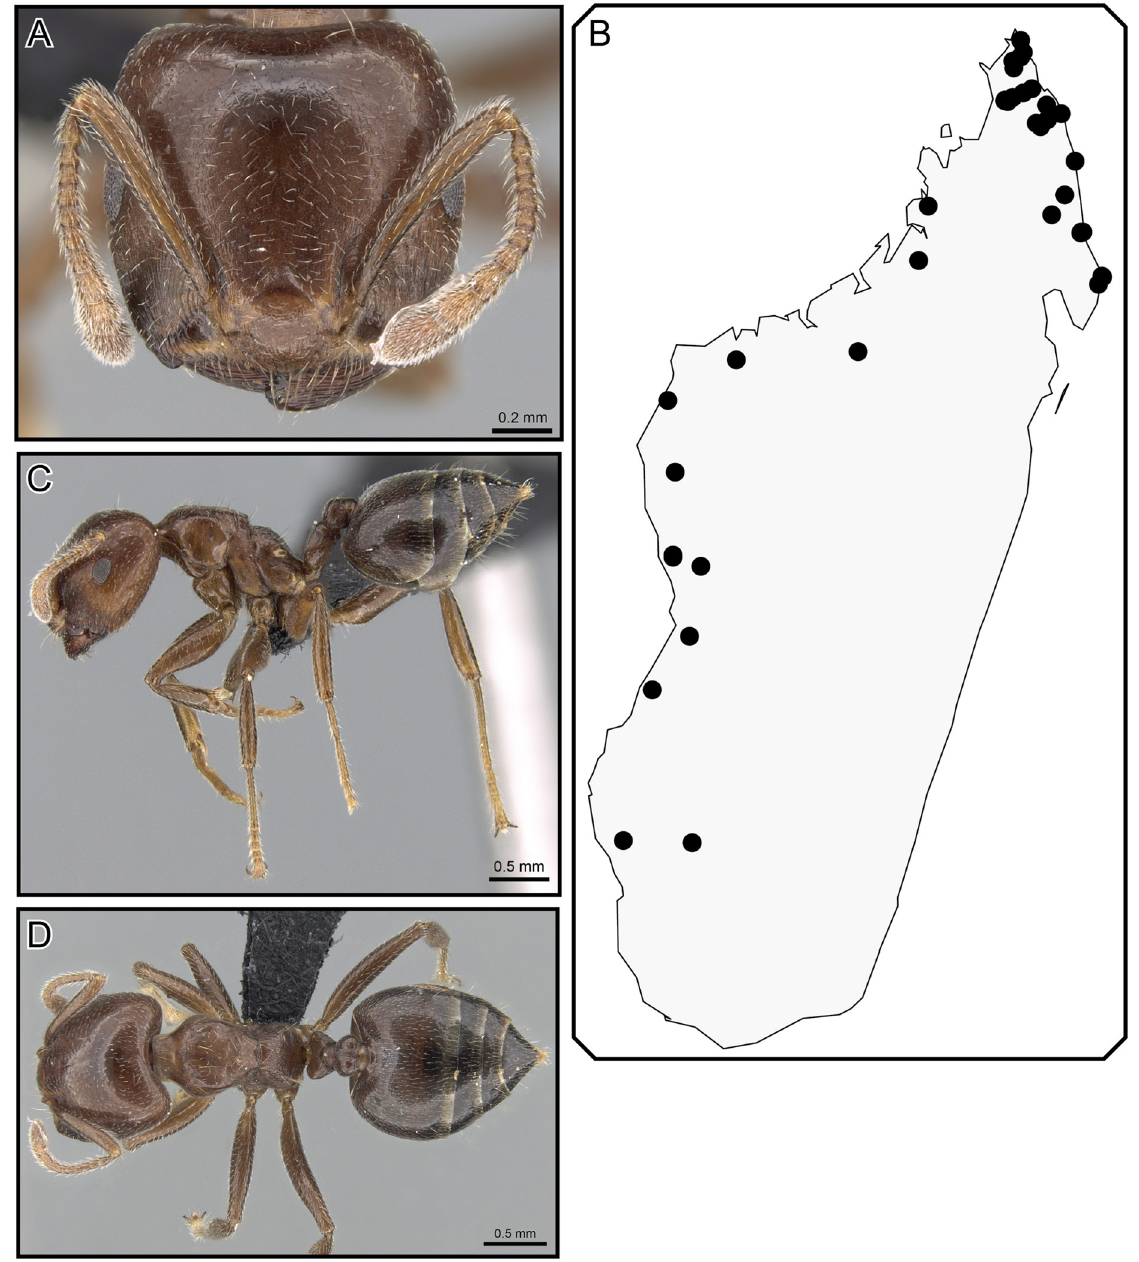
Fig. 12. Crematogaster lobata Emery, 1895, worker and distribution. A, C-D. Worker (CASENT0439060). A. Full-face. C. Profile. D. Dorsal. B. Species